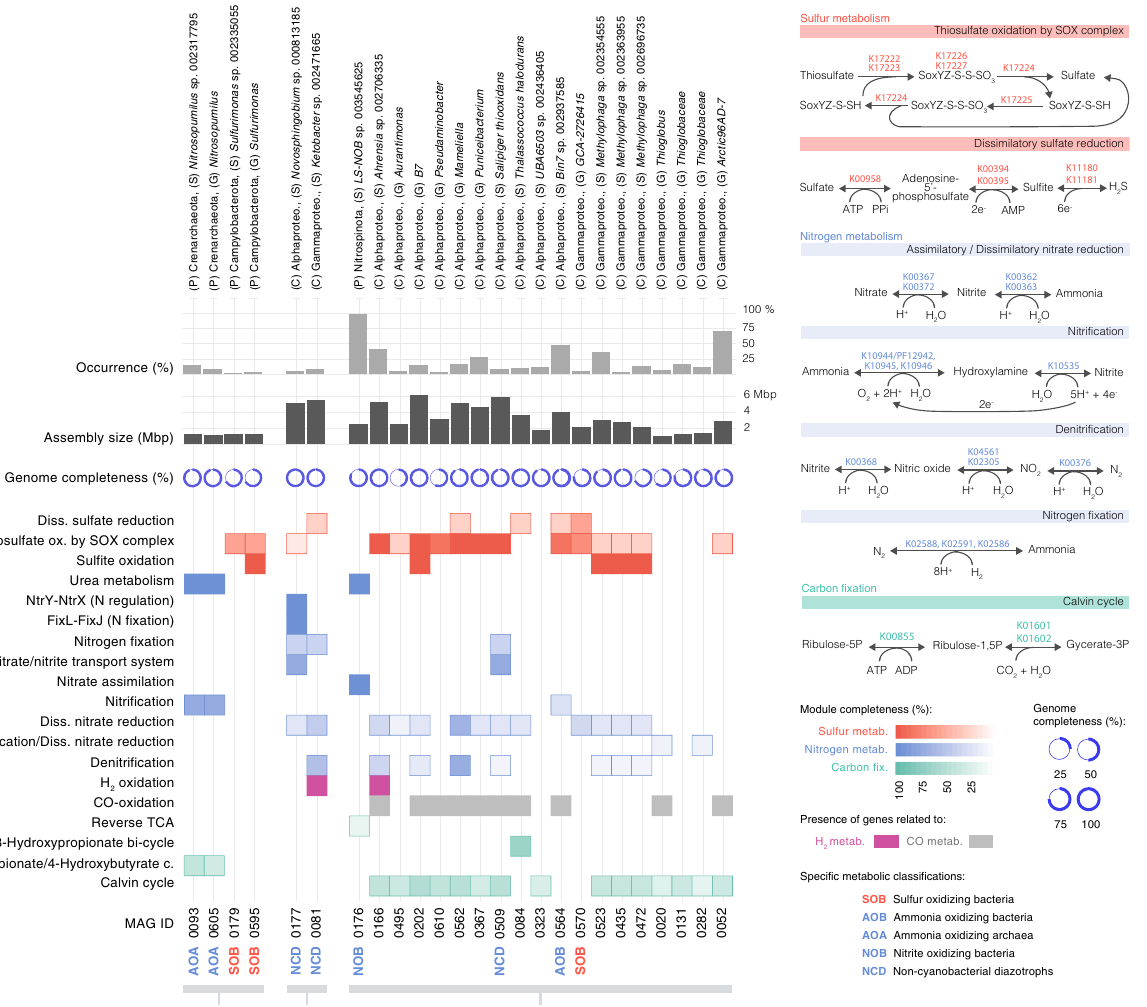
Fig. 6 Metabolic potential in selected metagenome-assembled genomes (MAGs) from the bathypelagic ocean. A total of 25 MDeep-MAGs were selected based on the presence of metabolic pathways with potential for chemolithoautotrophy, mixotrophy, and nitrogen fi xation (non-cyanobacterial diazotrophs, NCDs). AOA ammonia-oxidizing archaea, SOB sulfur-oxidizing bacteria, NCDs non-cyanobacterial diazotrophs, NOB nitrite-oxidizing bacteria, AOB ammonia-oxidizing bacteria. Their taxonomic assignment at the maximal possible resolution is shown at the top, followed by the occurrence of each MAG in samples of the Malaspina Gene DataBase, and the genome completeness (%) of each MAG. On the right, metabolic pathways involved in inorganic carbon fi xation (green), sulfur (red), nitrogen (blue) are shown as well as the KOs that participate in these pathways. At the bottom, the percentage module completeness for each pathway is coded by color